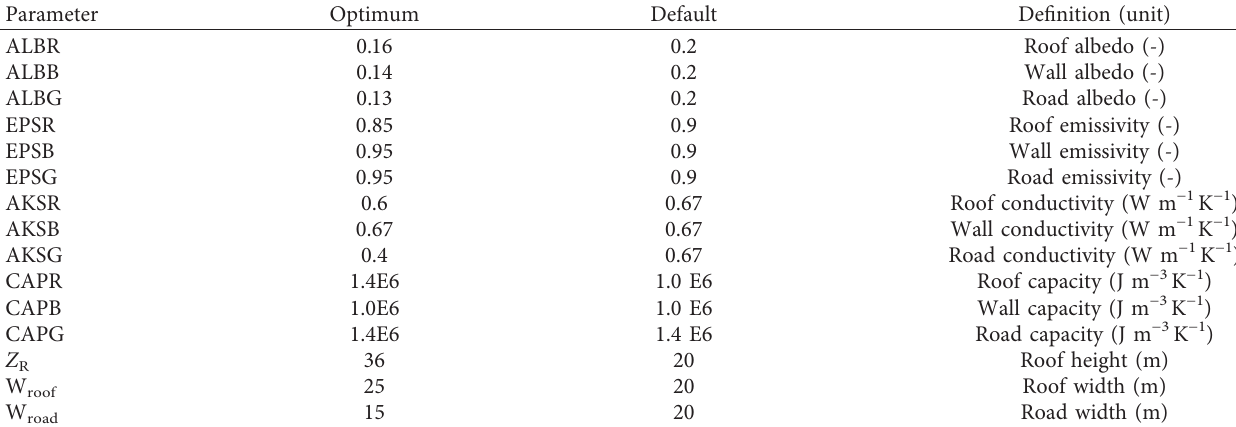
Table 2: The default and optimized SLUCM parameters.